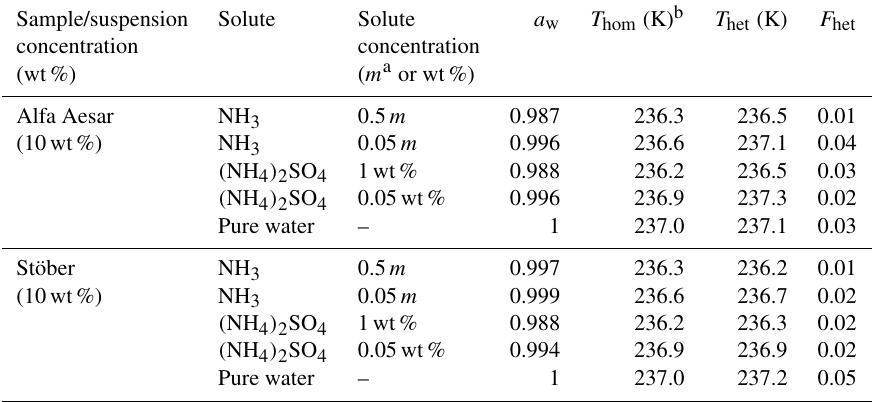
Table 2. Summary of the freezing experiments with emulsified aqueous solution droplets containing Alfa Aesar and Stöber amorphous silica particles (10wt%). Note that the absolute uncertainty in F het may be up to ± 0 .